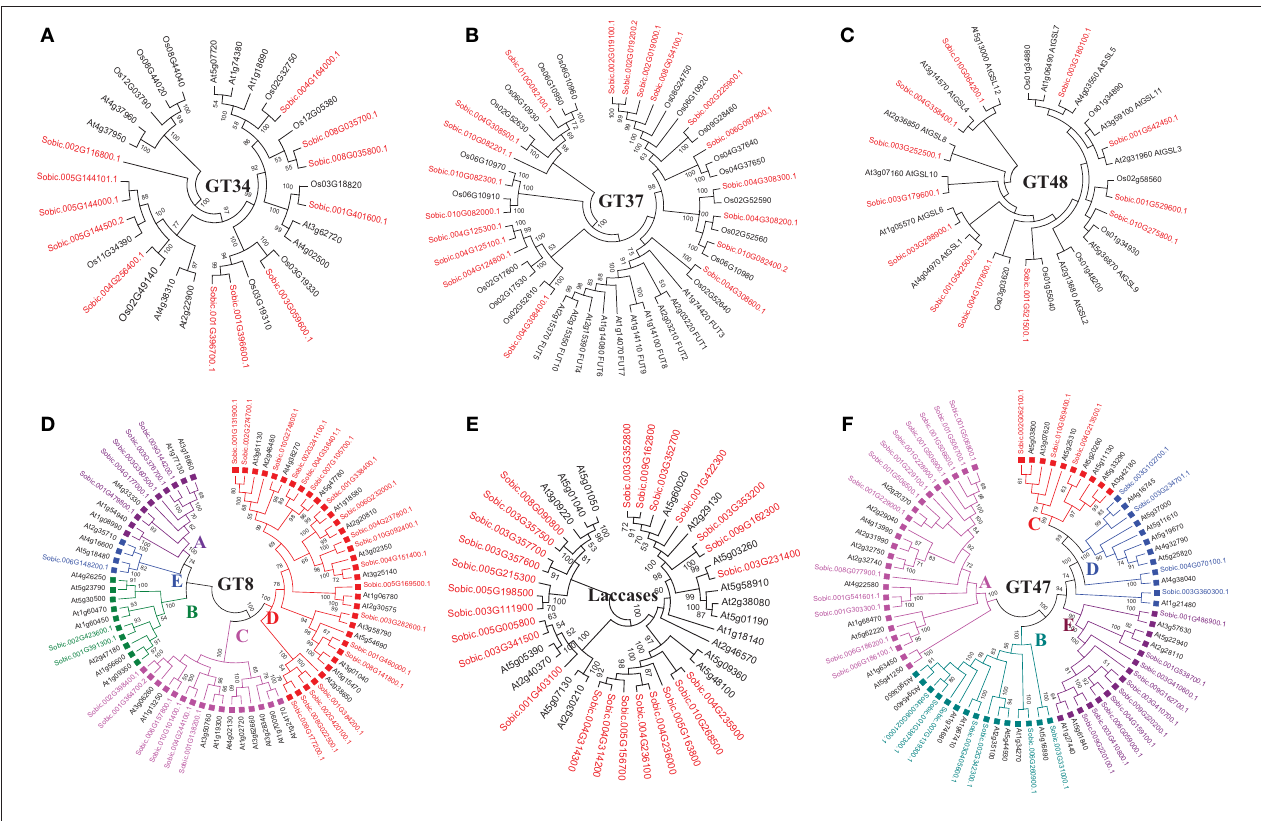
FIGURE 3 | Unrooted phylogenetic tree representing other cell wall related biosynthetic gene families. (A) Xyloglucan xylosyltransferases; GT34 (B) Xyloglucan fucosyltransferases; GT37 (C) Glucan synthase-like; GT48 (D) Homogalacturonan α -1,4-galacturonosyltransferases; GT8 (E) Laccases; AA1 (F) Xyloglucan galactosyltransferases; GT47. Same colored blocks and text represents the genes from similar